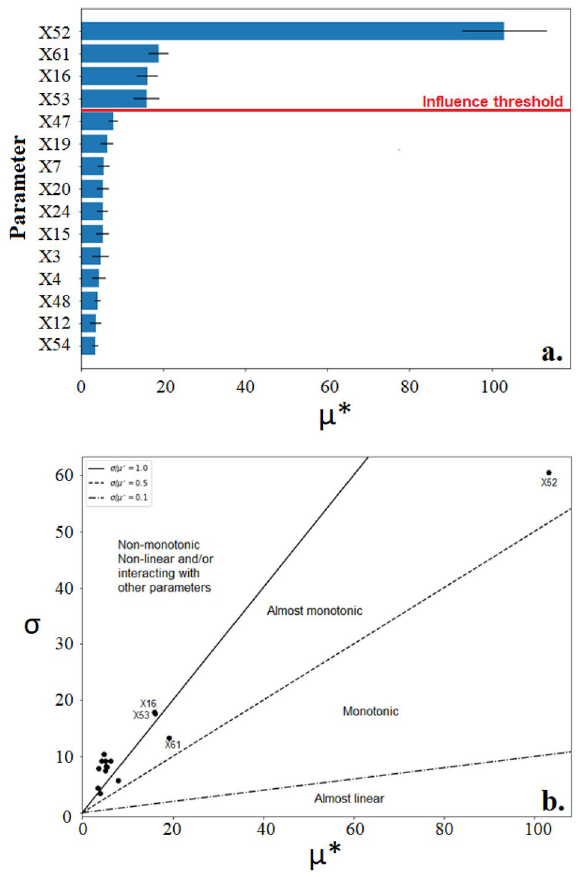
Figure 4. ( a ) The 15 parameters of greatest influence on the TSS output as demonstrated by the MoM displayed by ( a ). A horizontal bar chart with influence threshold 0.1 and ( b ) a Morris plot (σ/μ*).